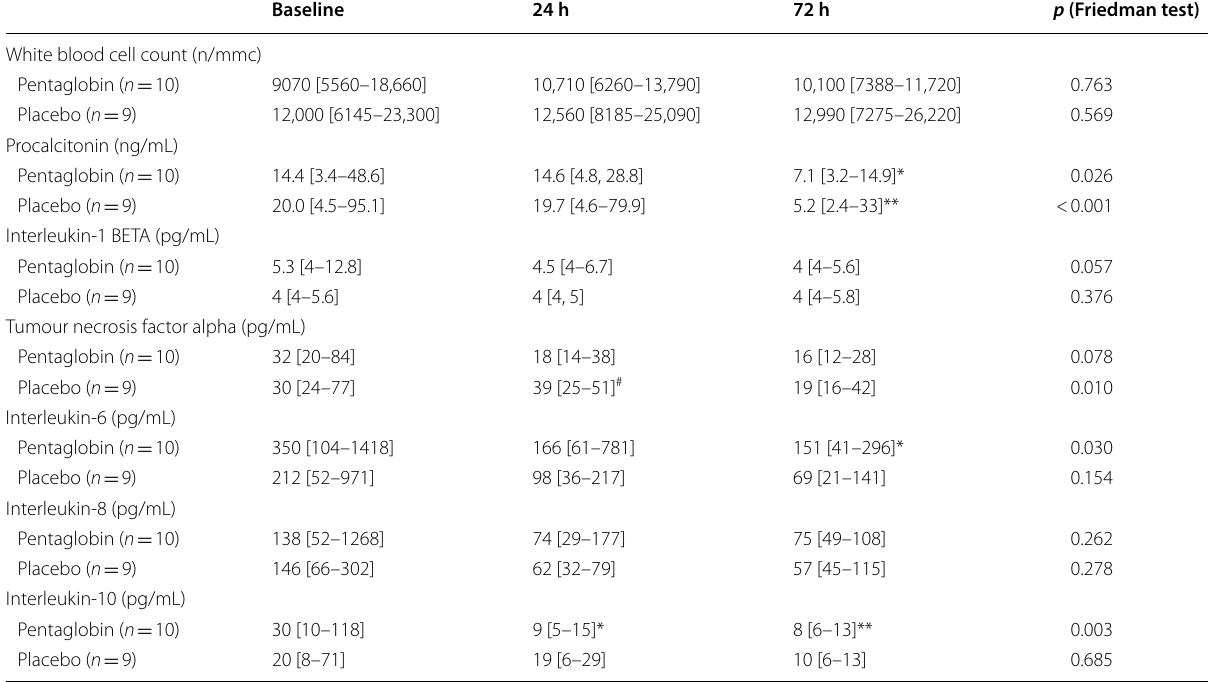
Table 4 White blood cells, procalcitonin and cytokine